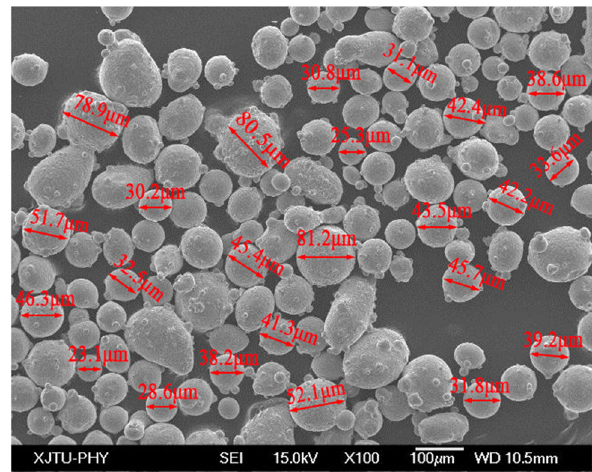
Figure 2: Morphology of 304 stainless steel powder particles.